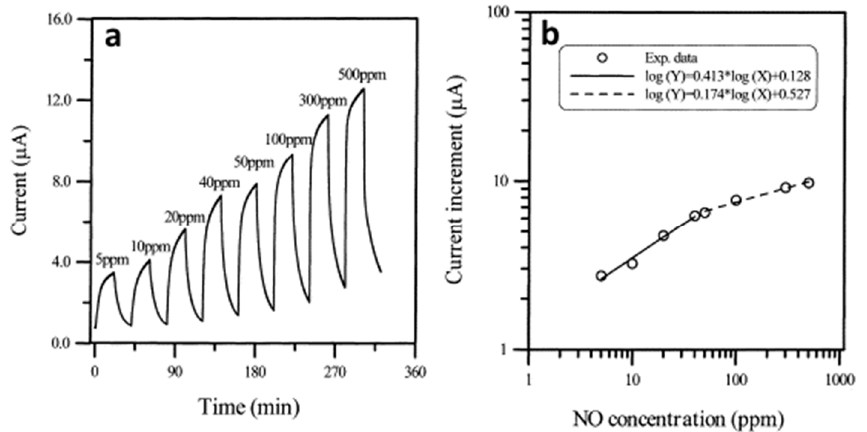
Figure 16. ( a ) Response current of NiPc film sequentially exposed to 5, 10, 20, 40, 50, 100, 300, and 500 ppm NO in N 2 at 160 ◦ C. Film thickness: 100 nm, substrate temperature: 25 ◦ C, evaporation rate: 0.1 nm/s, mass flow rate 200 mL/min, adsorption time: 20 min, desorption time: 20 min without aerating N 2 . ( b ) All-logarithmic plot of current increase vs. NO concentration. Adapted with permission from [93]. Copyright 2001 Elsevier. Table 2. Examples of phthalocyanine and porphyrin-based sensors used for the detection of gaseous NO.